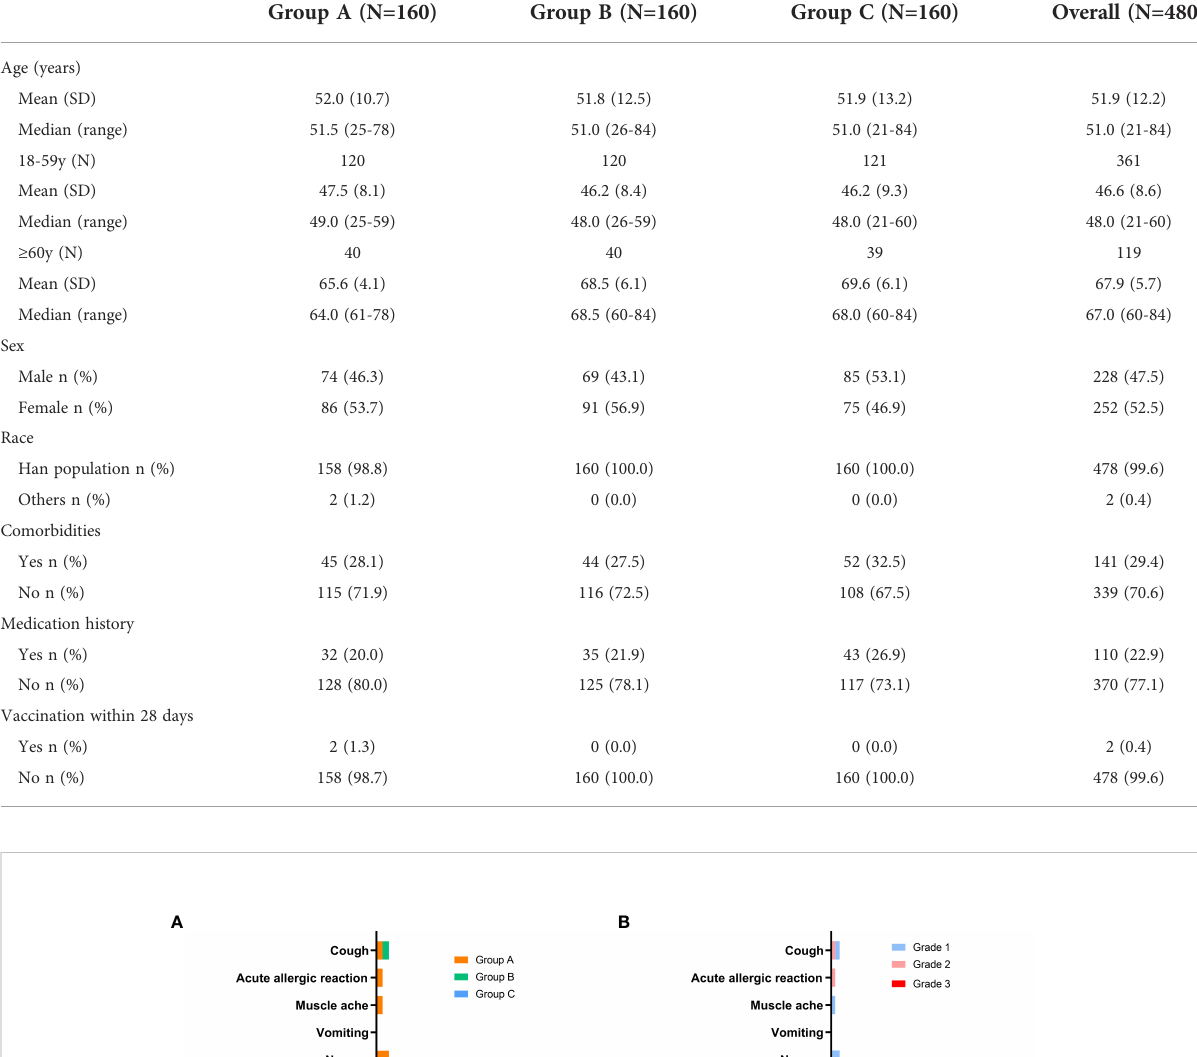
TABLE 1 Baseline characteristics of enrolled